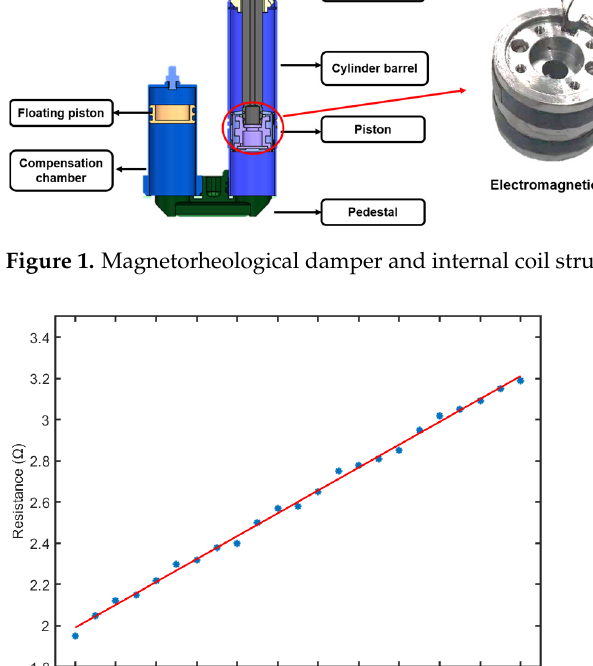
Figure 4. Equivalent circuit model added to load the main topology circuit switch model. 2.3. Calculation of Drive Circuit Parameters In order to reduce the circuit structure complexity and control difficulty of the current drive device, this paper selects the BTN8962TA integrated current half-bridge chip from Infineon (Neubiberg, Germany). The device includes a P-channel high-side MOSFET and an N-channel low-side MOSFET, eliminating the need for a charge pump. The chip integrates the drive logic unit and has the function of generating dead time internally.